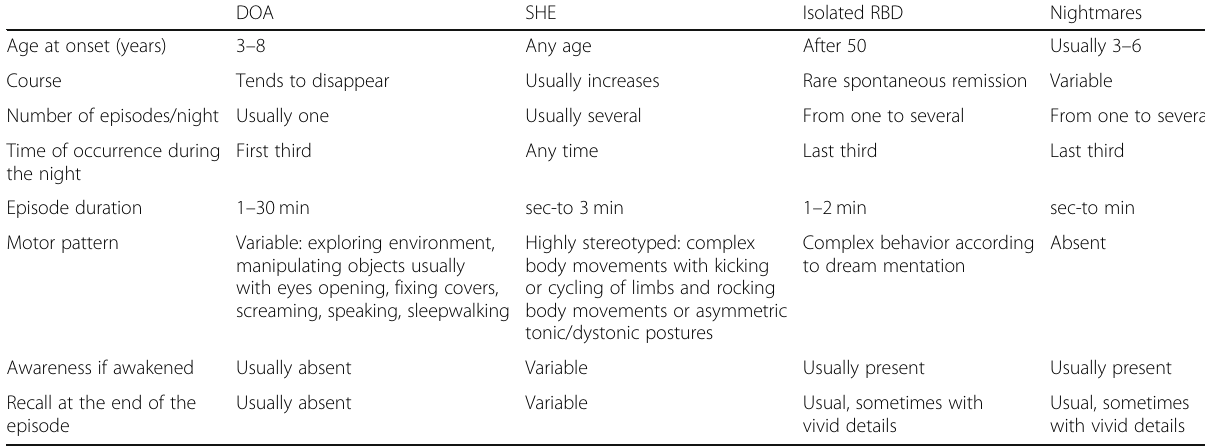
Table 2 Different features of Disorders of Arousal (DOA), Sleep-Related Hypermotor Epilepsy (SHE), Isolated REM Sleep Behavior Disorder (RBD) and Nightmares